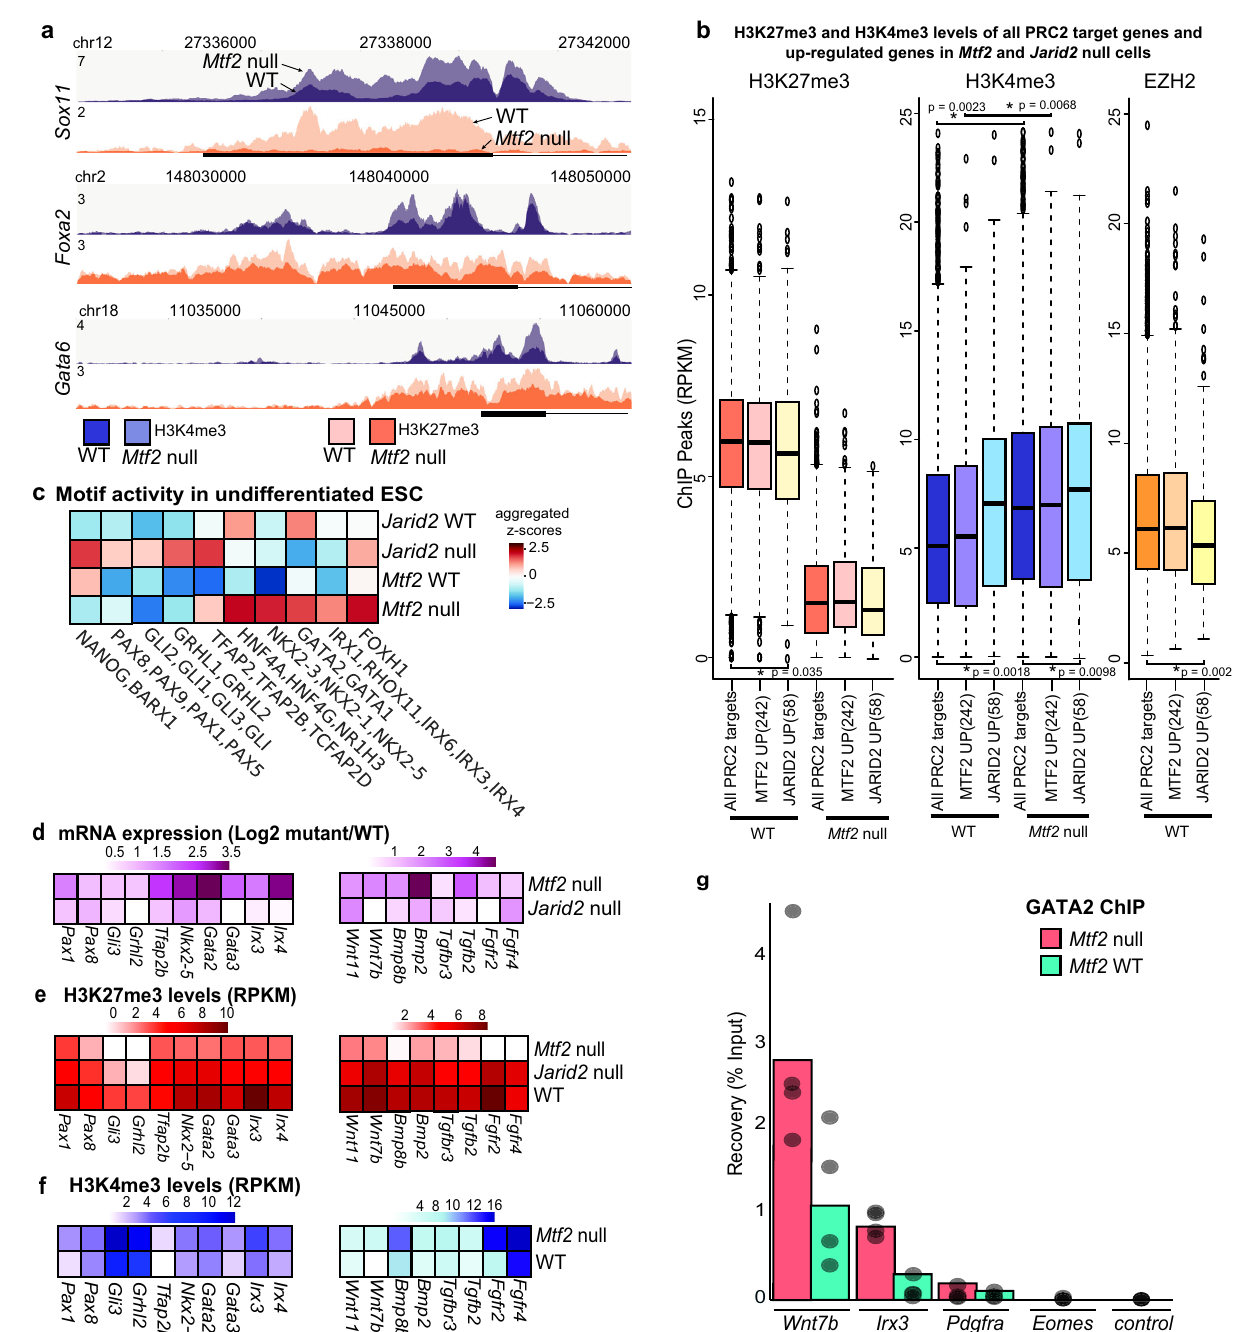
Fig. 5 Key PRC2-repressed lineage transcription factors are poised for activation. a ChIP peak pro fi les of histone mark H3K27me3 and H3K4me3 for selected upregulated ( Mtf2 null) lineage transcription factors for WT and Mtf2 null cells at pluripotent stage. ChIP pro fi les were RPKM normalized and scaled between two merged pro fi les per histone ChIP. b Boxplots depicting the RPKM values of promoter (as de fi ned by + / − 500 bp from TSS) H3K27me3, H3K4me3, and EZH2 for all PRC2 targets and the upregulated genes in Mtf2 null and Jarid2 null cells. Asterisk(*) represents a Two-sample Kolmogorov – Smirnov test p -value <0.05. n = 2878 for all PRC2 targets, n = 242 for upregulated Mtf2 null genes and n = 58 for upregulated Jarid2 null genes. Whisker ends of boxplot represent the maximum (top) and minimum values, respectively. Top and bottom of boxplots represent 75th and 25th percentile values, respectively, and fi nally, median values are shown as colored lines within the boxplots. c Transcription factor motif activity that explains part of the variance in transcript levels, based on motifs in the promoters (as de fi ned by + / − 500 bp from TSS) of all upregulated PRC2-bound genes ( “ Methods ” ; upregulated genes in all four cell lines, cf. Fig. 4b). Motifs are shown in aggregated z-scores. d – f Heatmaps showing the mRNA fold change, H3K27me3 and H3K4me3 levels for a set of transcription factors (left, identi fi ed in panel c ) and signaling factors (right, identi fi ed from Mtf2 and Jarid2 null DEGs list). Genes shown are all PRC2 targets. g Barplot depicting the GATA2 ChIP recovery relative to input. Control is a gene desert region ( “ Methods ” ). Dots in bars represent 4 replicates per